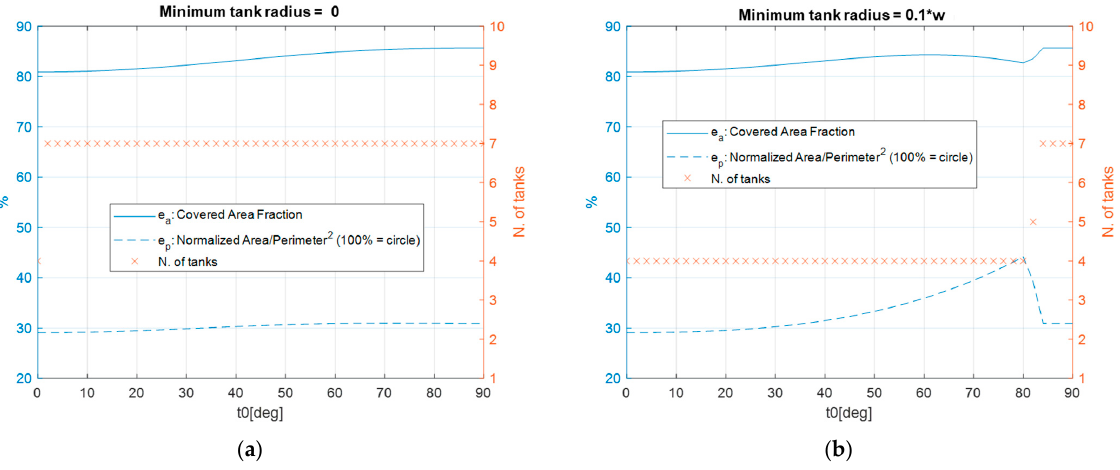
Figure 9. Geometric performance of full-section layout for f = 0.75 and various t 0 values: ( a ) no constraints on minimum radius values, ( b ) minimum radius set to 10% of fuselage half-width.